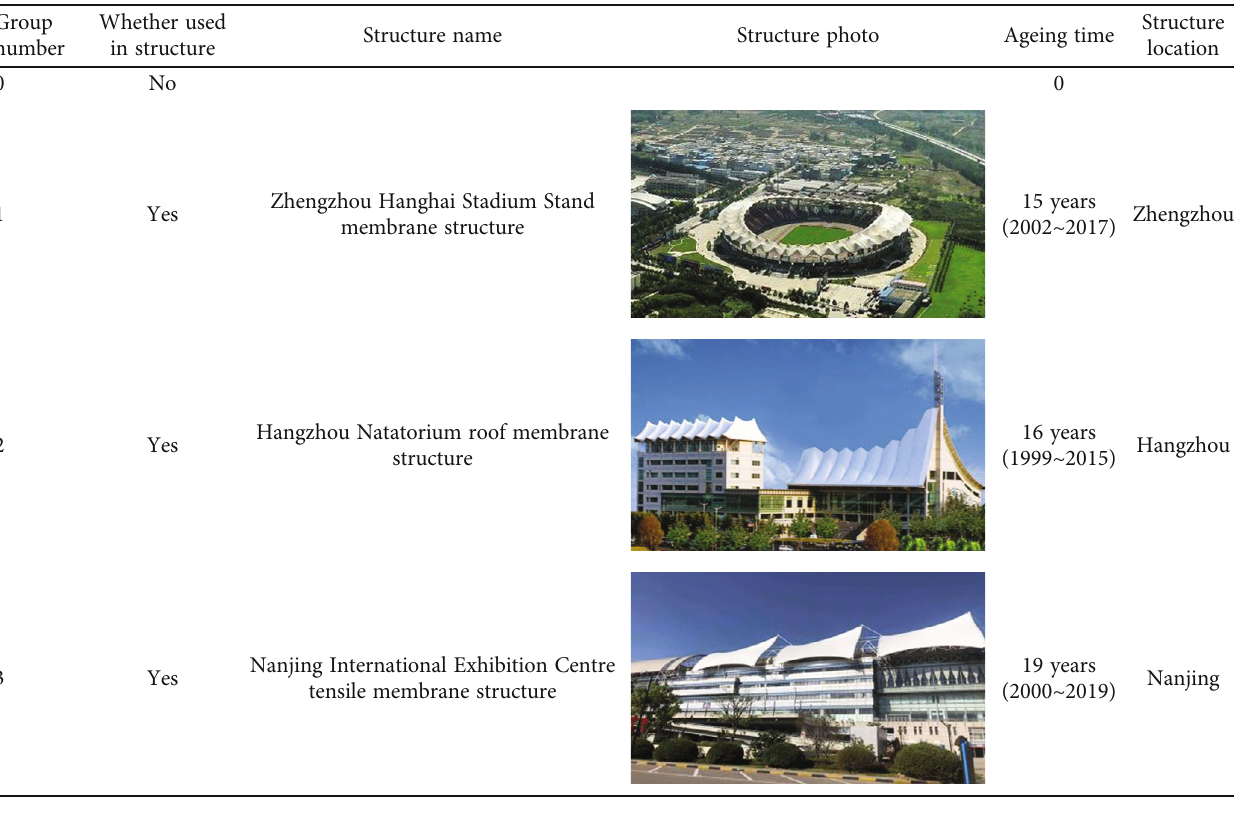
Table 1: Detailed information about tested PVDF-coated fabrics.